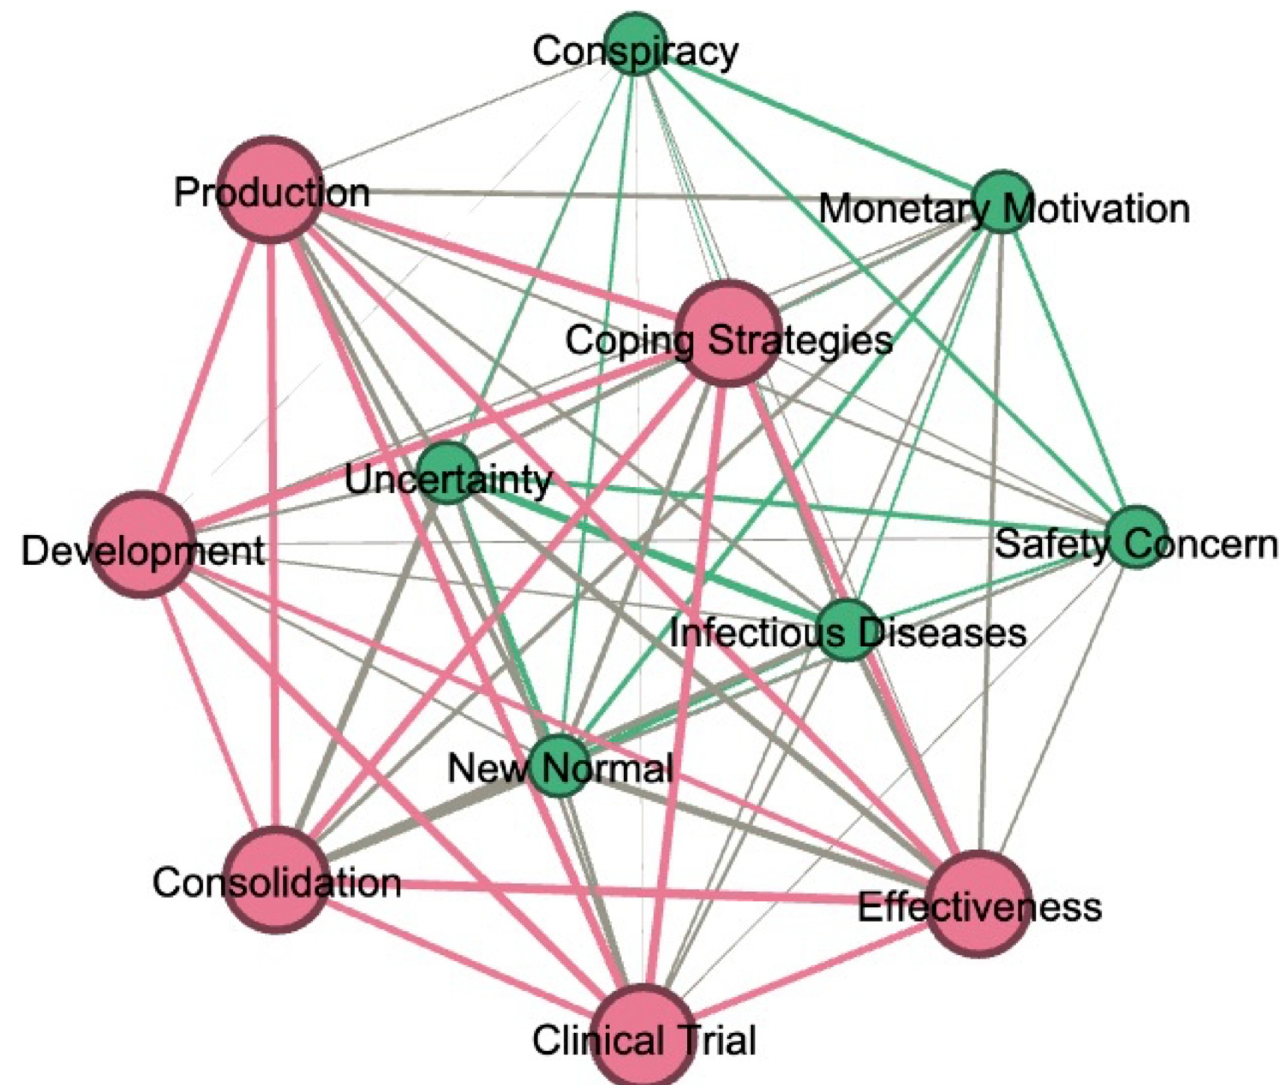
Fig 3. A semantic network with nodes as topics and edges as their